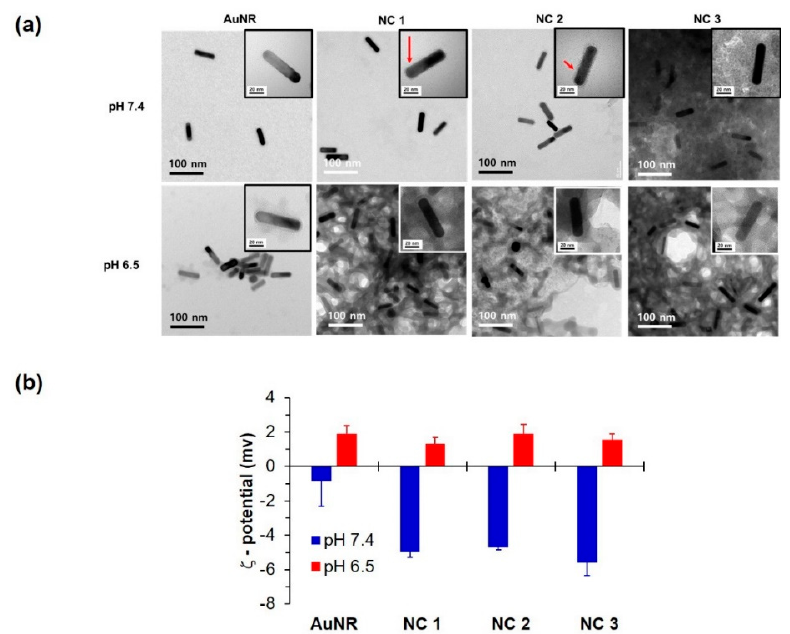
Figure 1. Characterization of nanocluster (NC) systems: ( a ) morphologies by transmission electron microscopy (TEM) at pH 7.4 and 6.5, and ( b ) zeta potential at pH 7.4 and 6.5 of gold nanorod (AuNR) and NC systems at different pH conditions (pH 7.4 and 6.5).